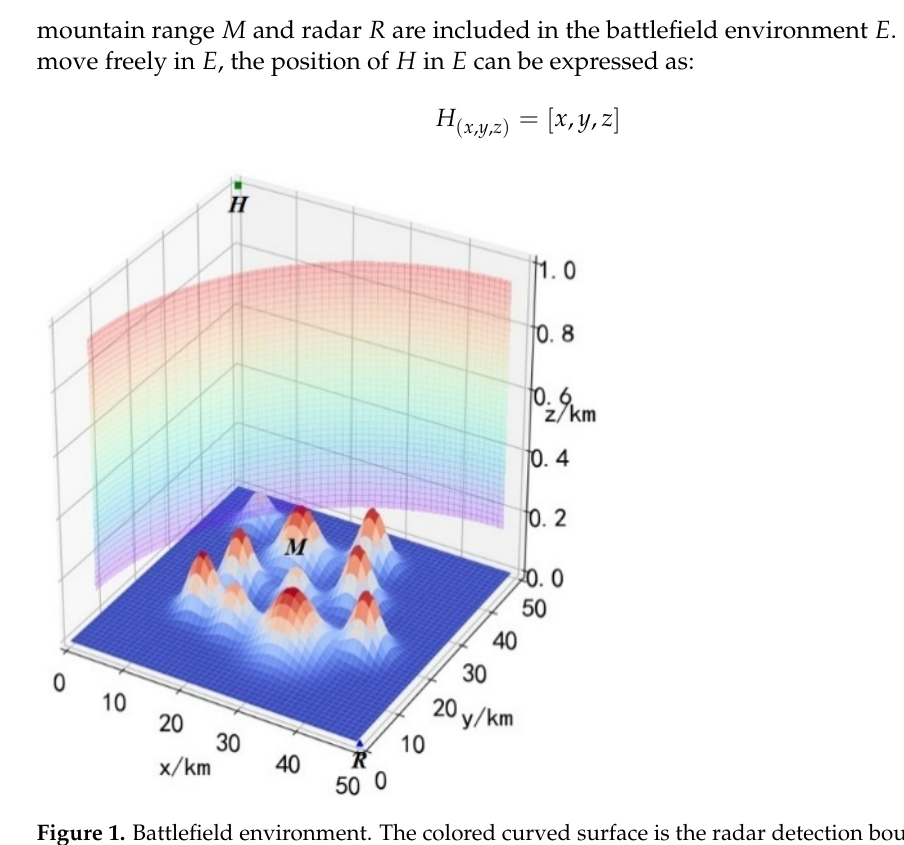
Figure 2. Movement of unmanned helicopters.